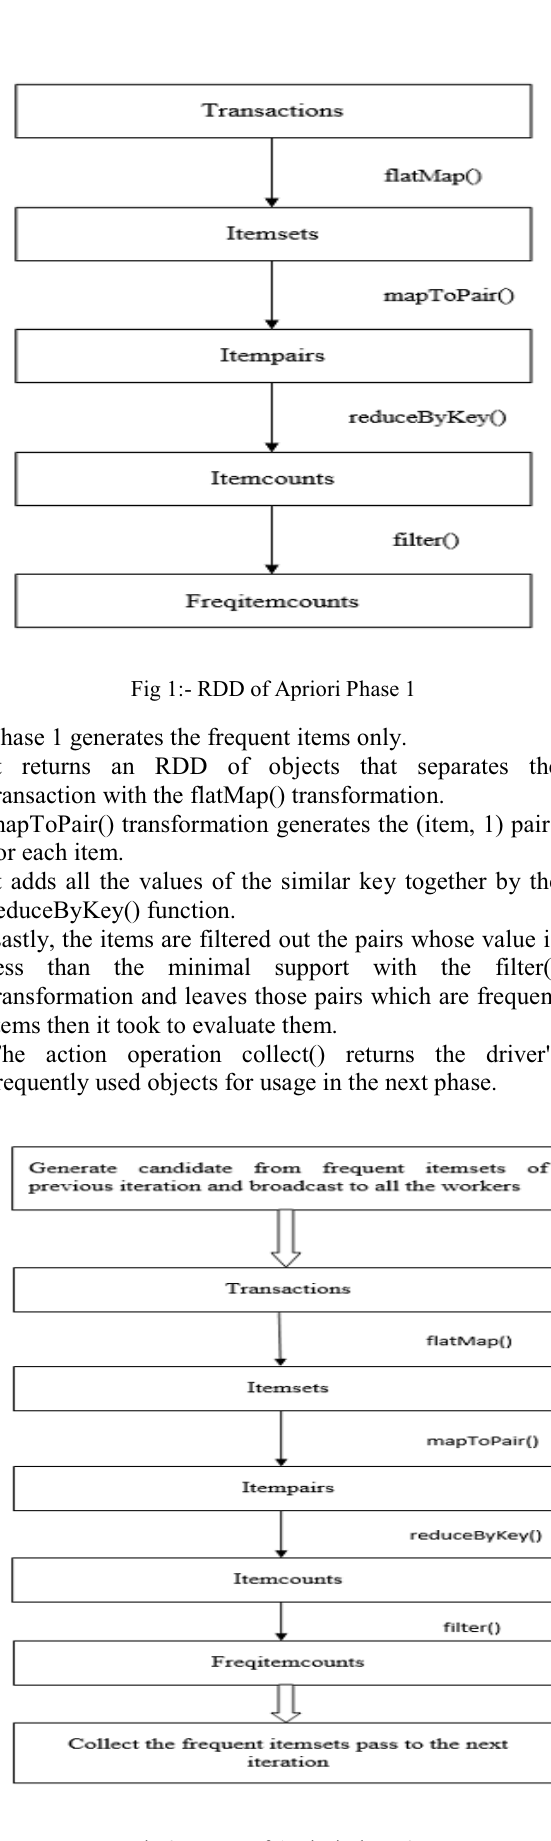
Fig 2:- RDD of Apriori Phase 2